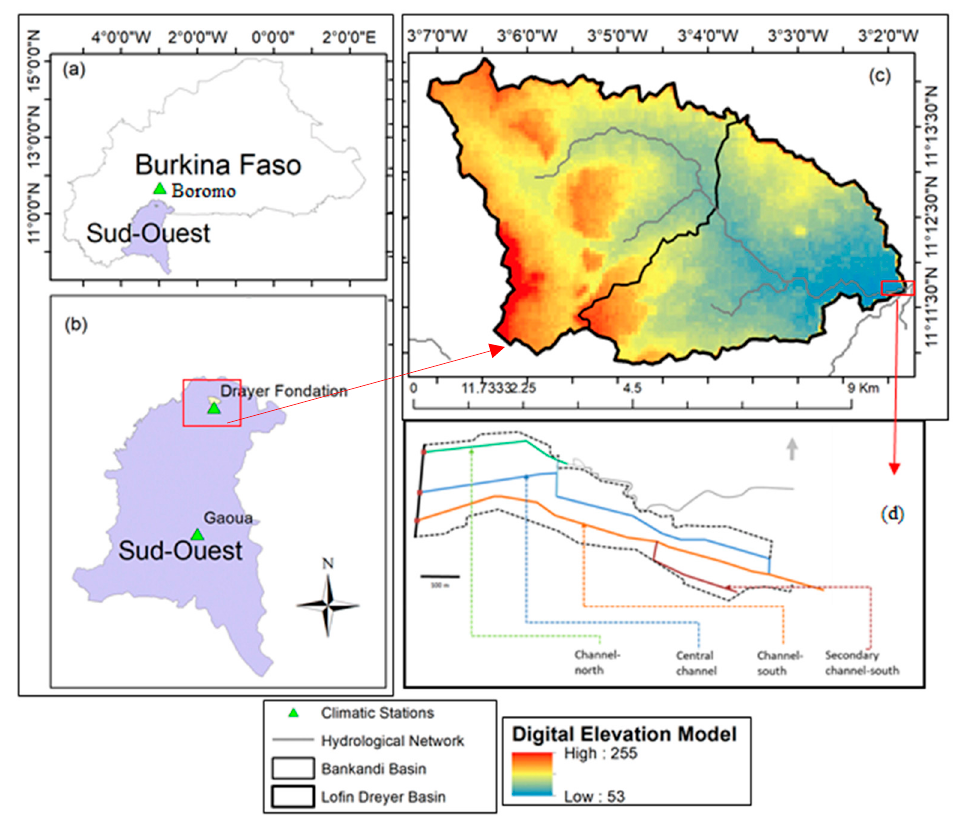
Figure 1. ( a ) Location of the study area in Burkina Faso. ( b ) The southwest region. ( c ) The Lofin catchment. ( d ) The Lofin inland-valley with irrigation/drainage channels.